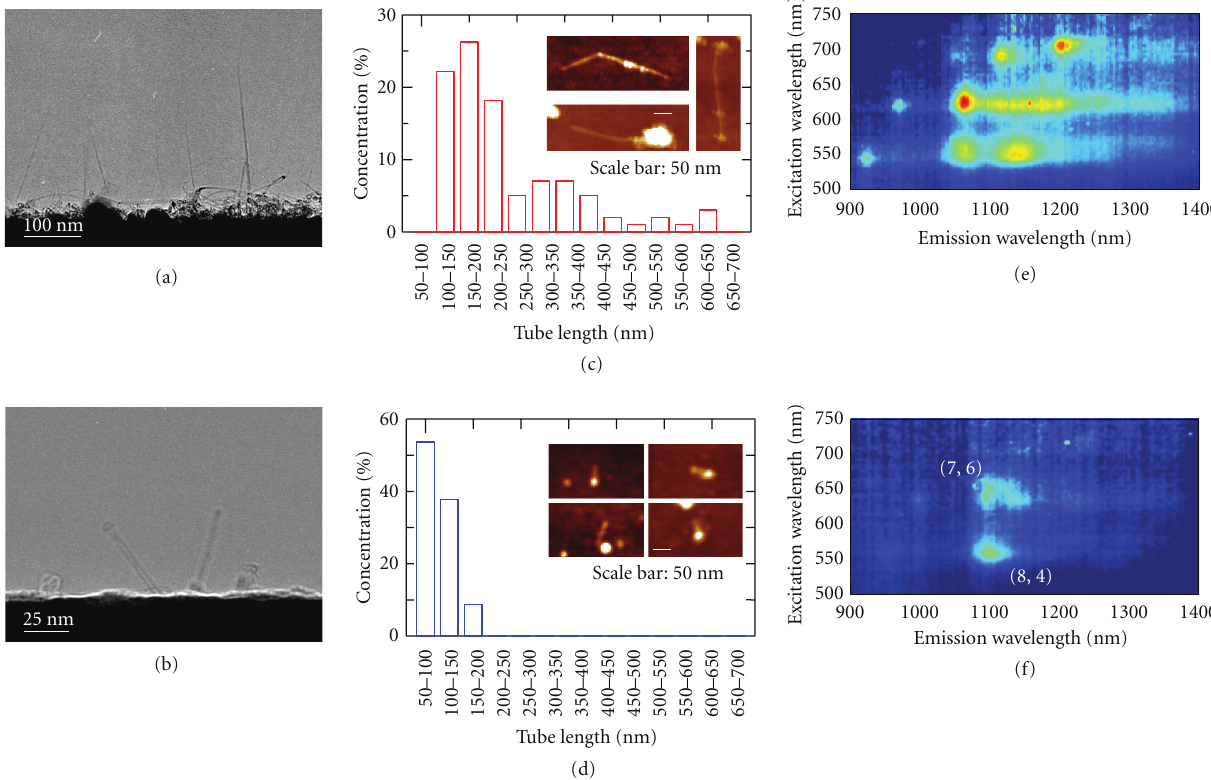
Figure 5: (a, b) TEM images of freestanding SWNTs produced by long (a) and short (b) growth times. (c, d) Length distributions of SWNTs produced by long (c) and short (d) growth times. The inset shows a typical AFM image of SWNTs used for length estimation. (e, f) PLE map of SWNTs grown for long (e) and short (f) times.